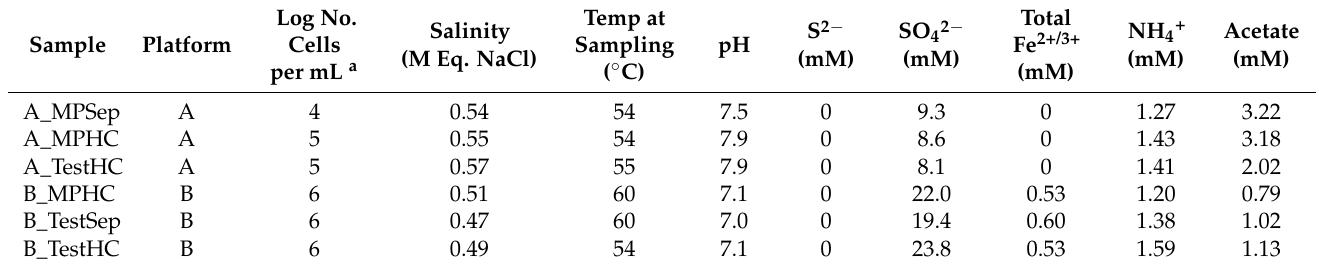
Table 1. Characteristics of the produced water samples collected from each location on the topsides of Platforms A and